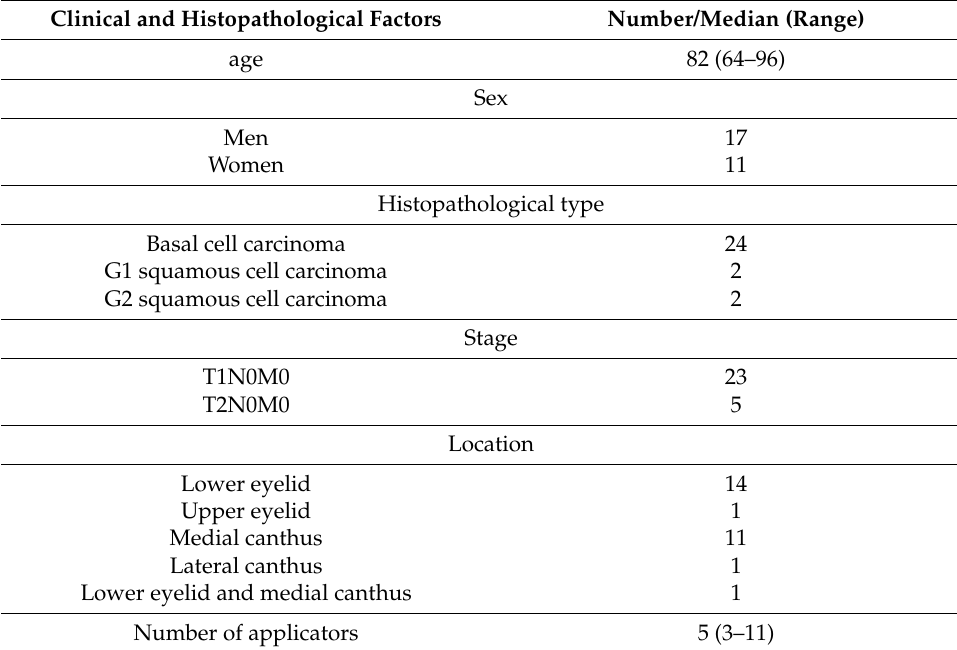
Table 1. The clinical and histopathological characteristics of